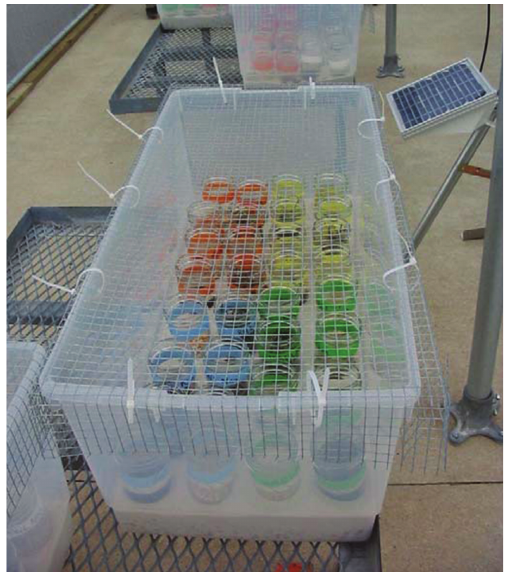
Figure 2: Photograph of samples of M. bovis inoculated substrates in their primary containers placed within their secondary contain- ers inside the experimental environmentalsample enclosure. Shown here are the “nonshaded” treatments from 4 sample sets (total of 32 sample jars).